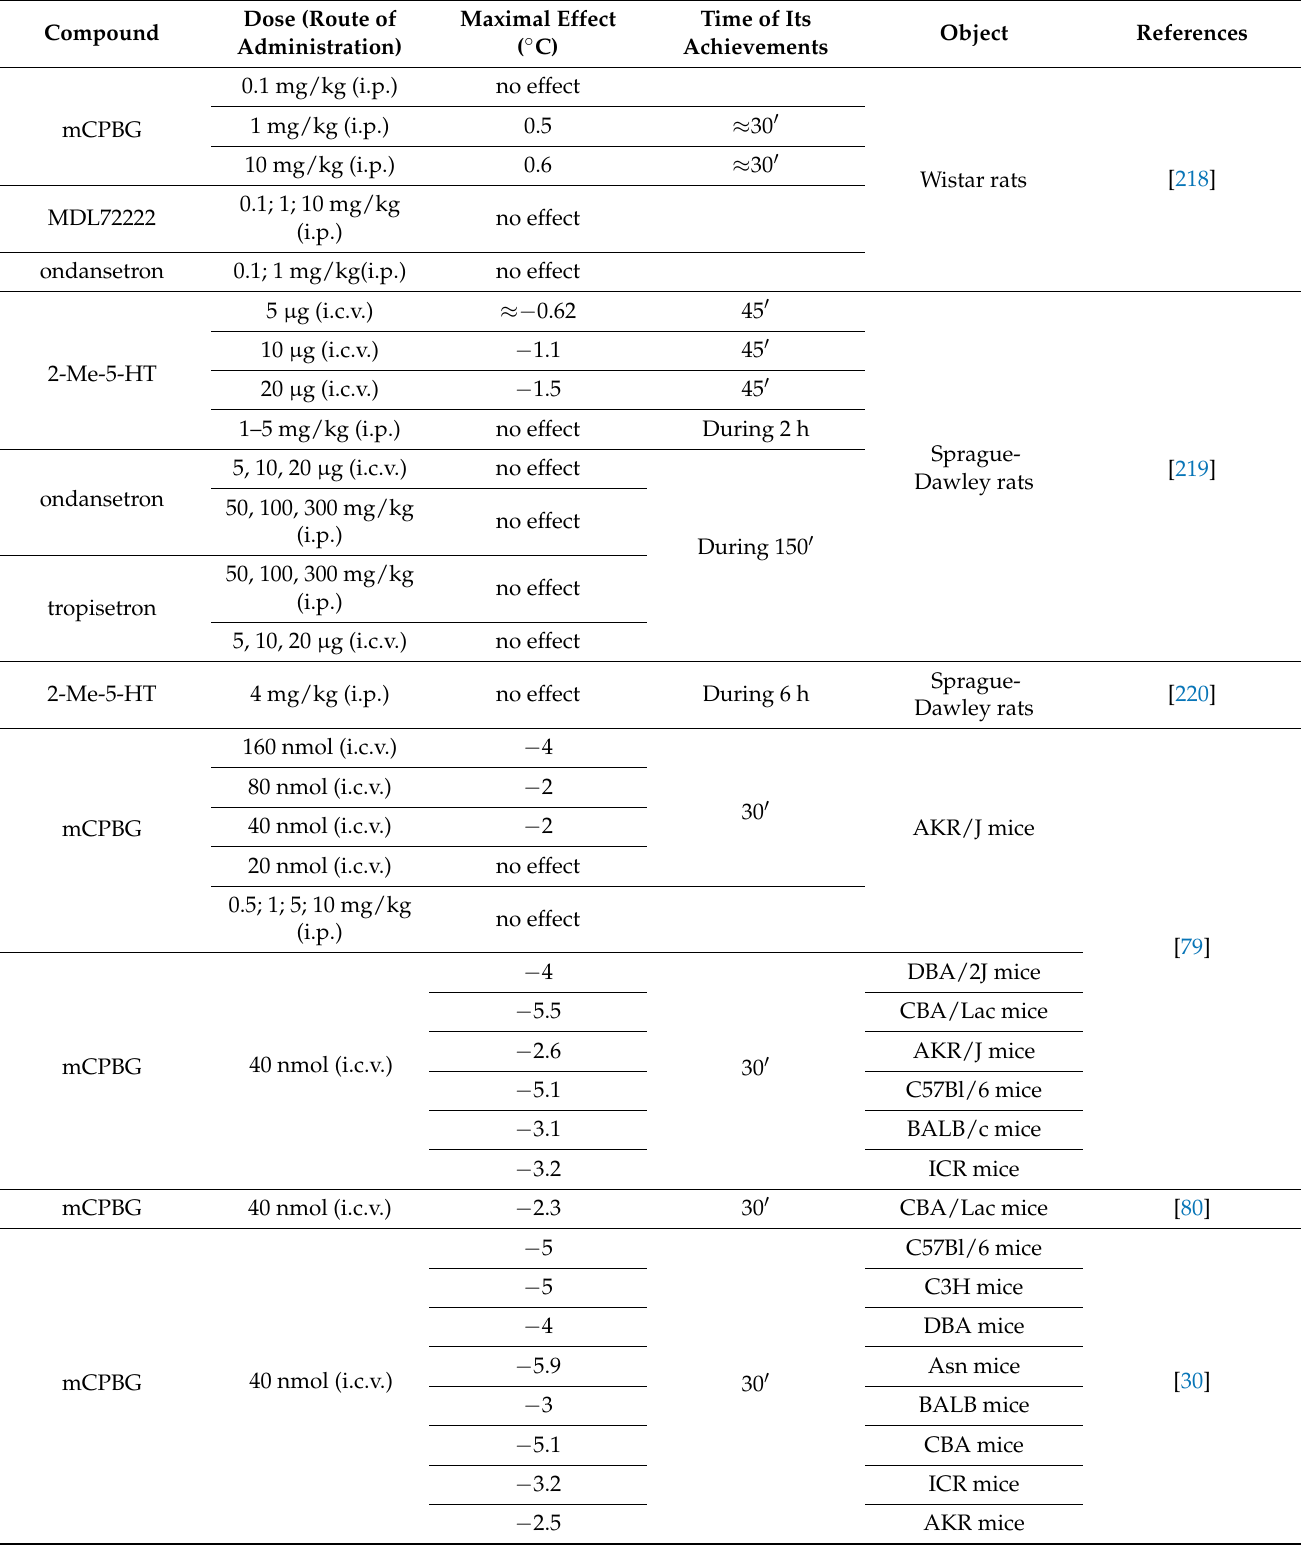
Table 7. Effect of 5-HT 3 agonists and antagonists on body temperature in warm-blooded animals. Dose (Route of Maximal Effect Time of Its Compound Administration) ( ◦ C) Achievements